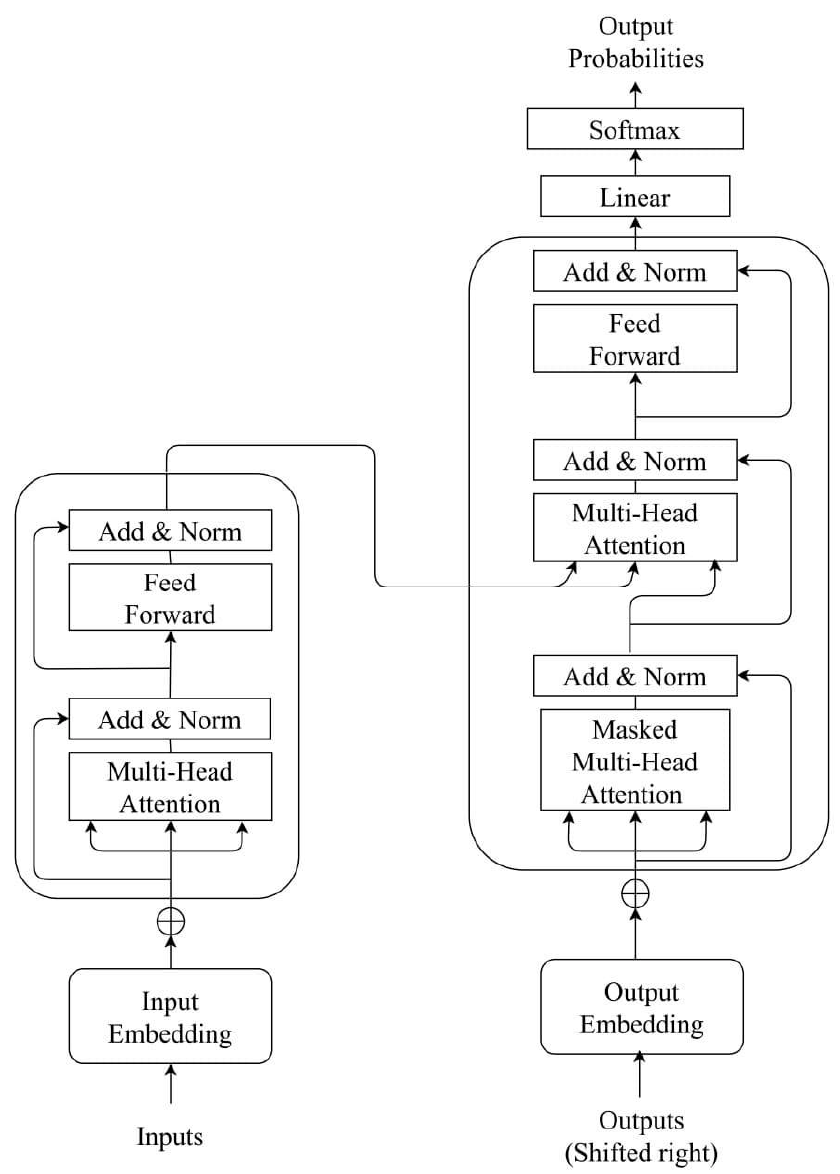
Figure 3. Architecture of the transformer model.